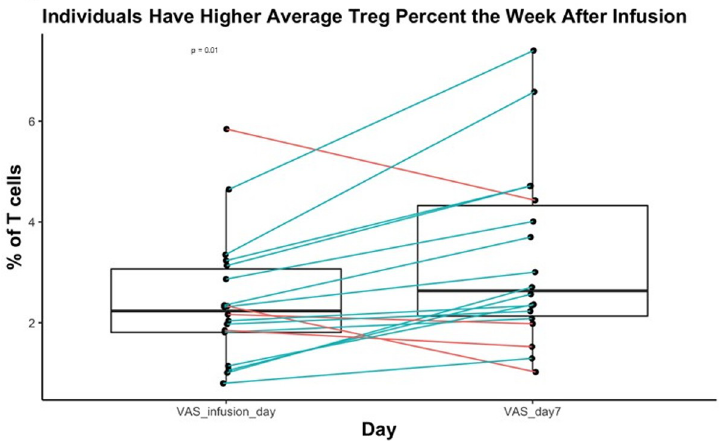
Fig 3. Proportion of T cells with Treg Phenotype increases from pre-infusion to day 7. Paired boxplot representing the change in Tregs as a percentage of CD4+ T cells from the pre-infusion blood draw to day 7. Treg% was averaged for each subject before infusion and on day 7. P-value is derived from the random effects model of the relationship between day 7 and the pre-infusion draw.